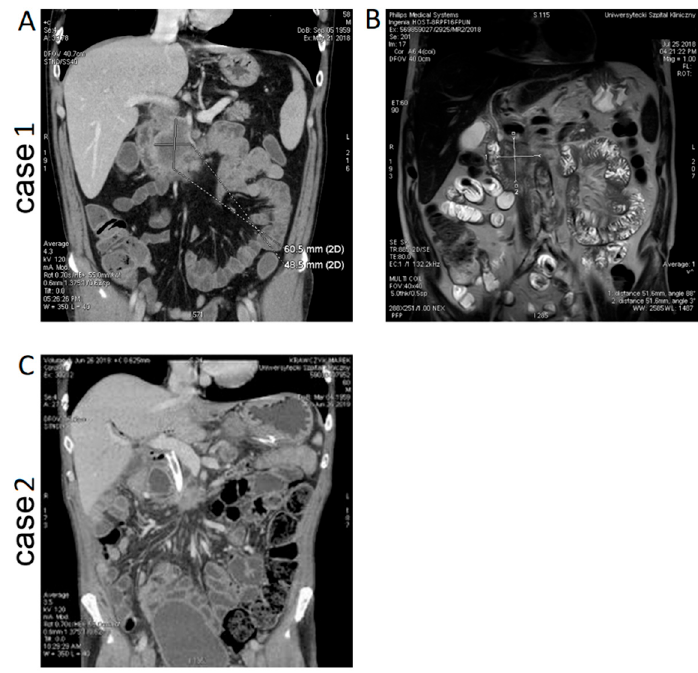
Figure 1. Patients’ imaging before the irreversible electroporation (IRE) procedure ( A ) Case 1. CT (computerized tomography) examination after the administration of the contrast agent showed a hypodense tumor mass at the head of the pancreas (61 × 49 mm) infiltrating the mesenteric and portal vein (not visible in the image); ( B ) Case 1. MRI (magnetic resonance imaging) examination (sequence T2-dependent) before electrochemotherapy showed the presence of a tumor of size 52 × 52 mm at the head of the pancreas and a heterogeneous signal; ( C ) Case 2. CT examination after the administration